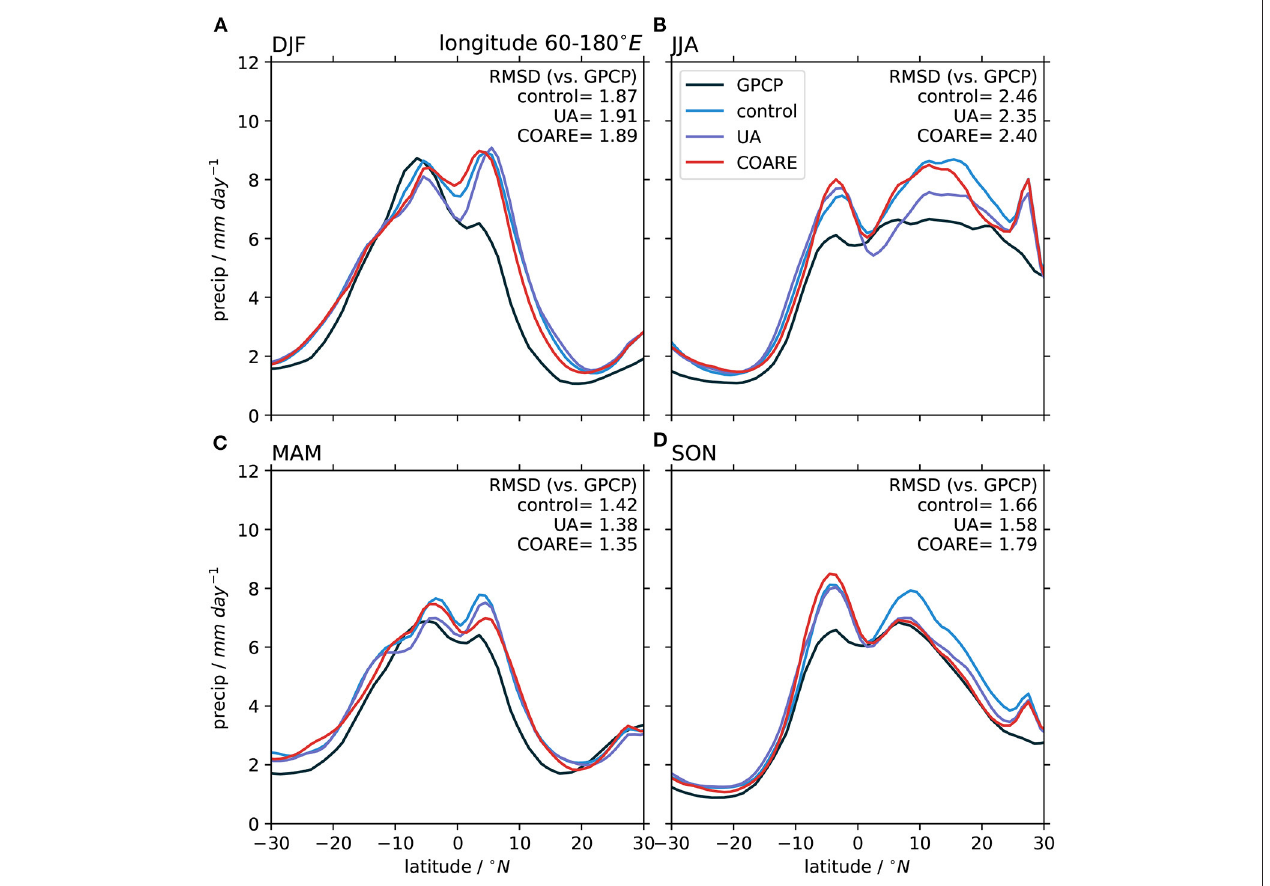
FIGURE 7 | Zonal mean, seasonal mean precipitation from the three atmosphere simulations and GPCP observational data: (A) December to February; (B) June to August; (C) March to May; (D) September to November. The zonal sector considered is 60 ◦ E to 180 ◦ E. GPCP data were bilinearly interpolated to the same 1 ◦ grid as the other data before calculating. Text in each panel shows the area-weighted root mean square difference, in mm day − 1 , between each model and the GPCP data, calculated from gridded data rather than from the zonal means.